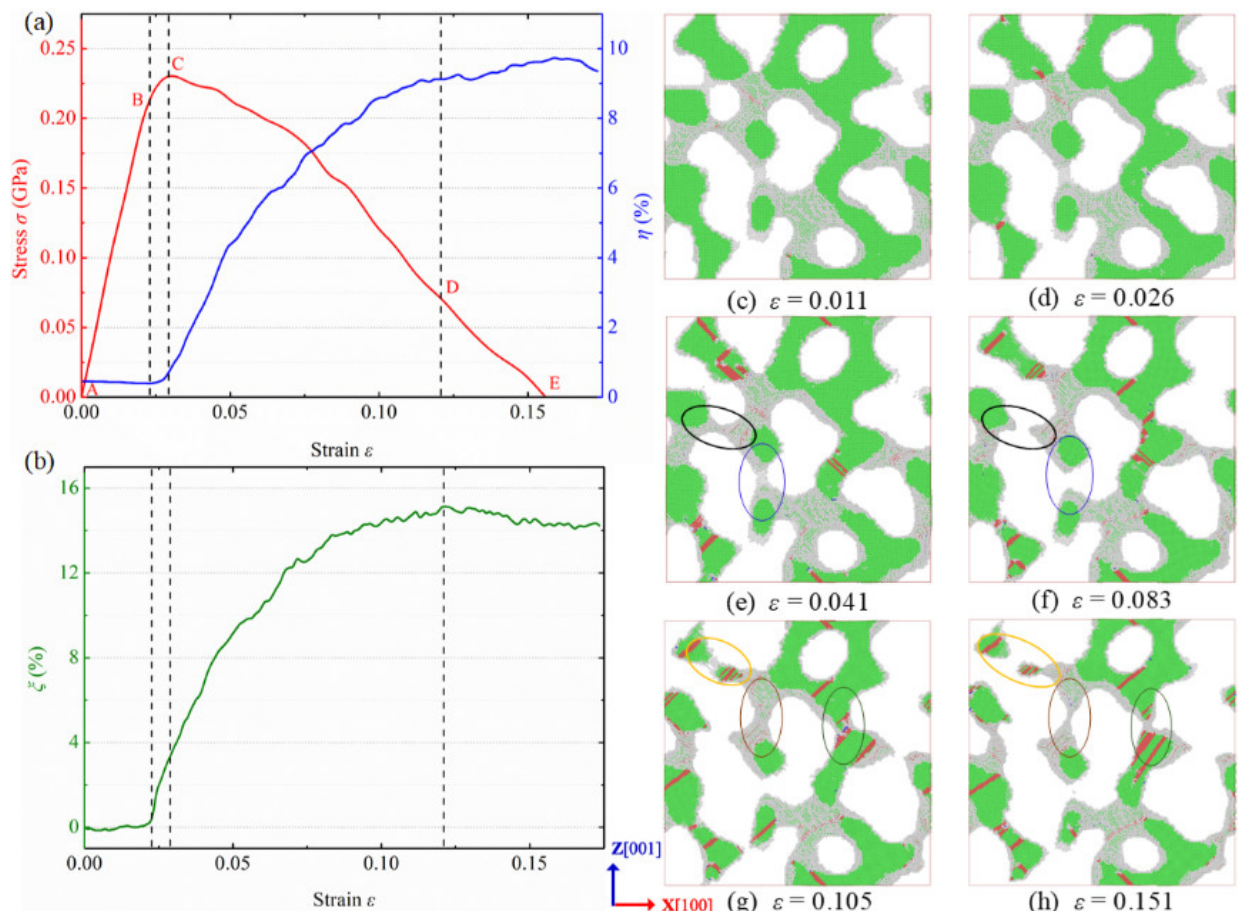
Figure 4. Variations of ( a ) stress along the X [100] direction (left, red), and HCP atom fraction η (left, blue), and ( b ) surface atom fraction ξ of nanoporous gold under the loading along X [100] and Z [001] directions with the applied strain. Microstructure evolution of NPG in biaxial tension with applied strains of ( c ), ε = 0.011, ( d ) ε = 0.026, ( e ) ε = 0.041, ( f ) ε = 0.083, ( g ) ε = 0.105, and ( h ) ε = 0.151. Atoms are colored by the CNA method, and a slice between y = 19.3 nm and y = 21.8 nm is shown.